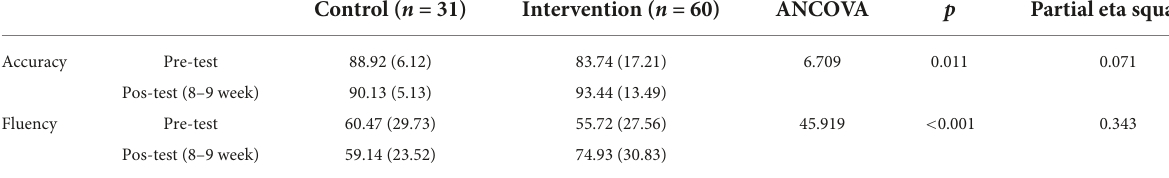
TABLE 5 Intervention outcomes.